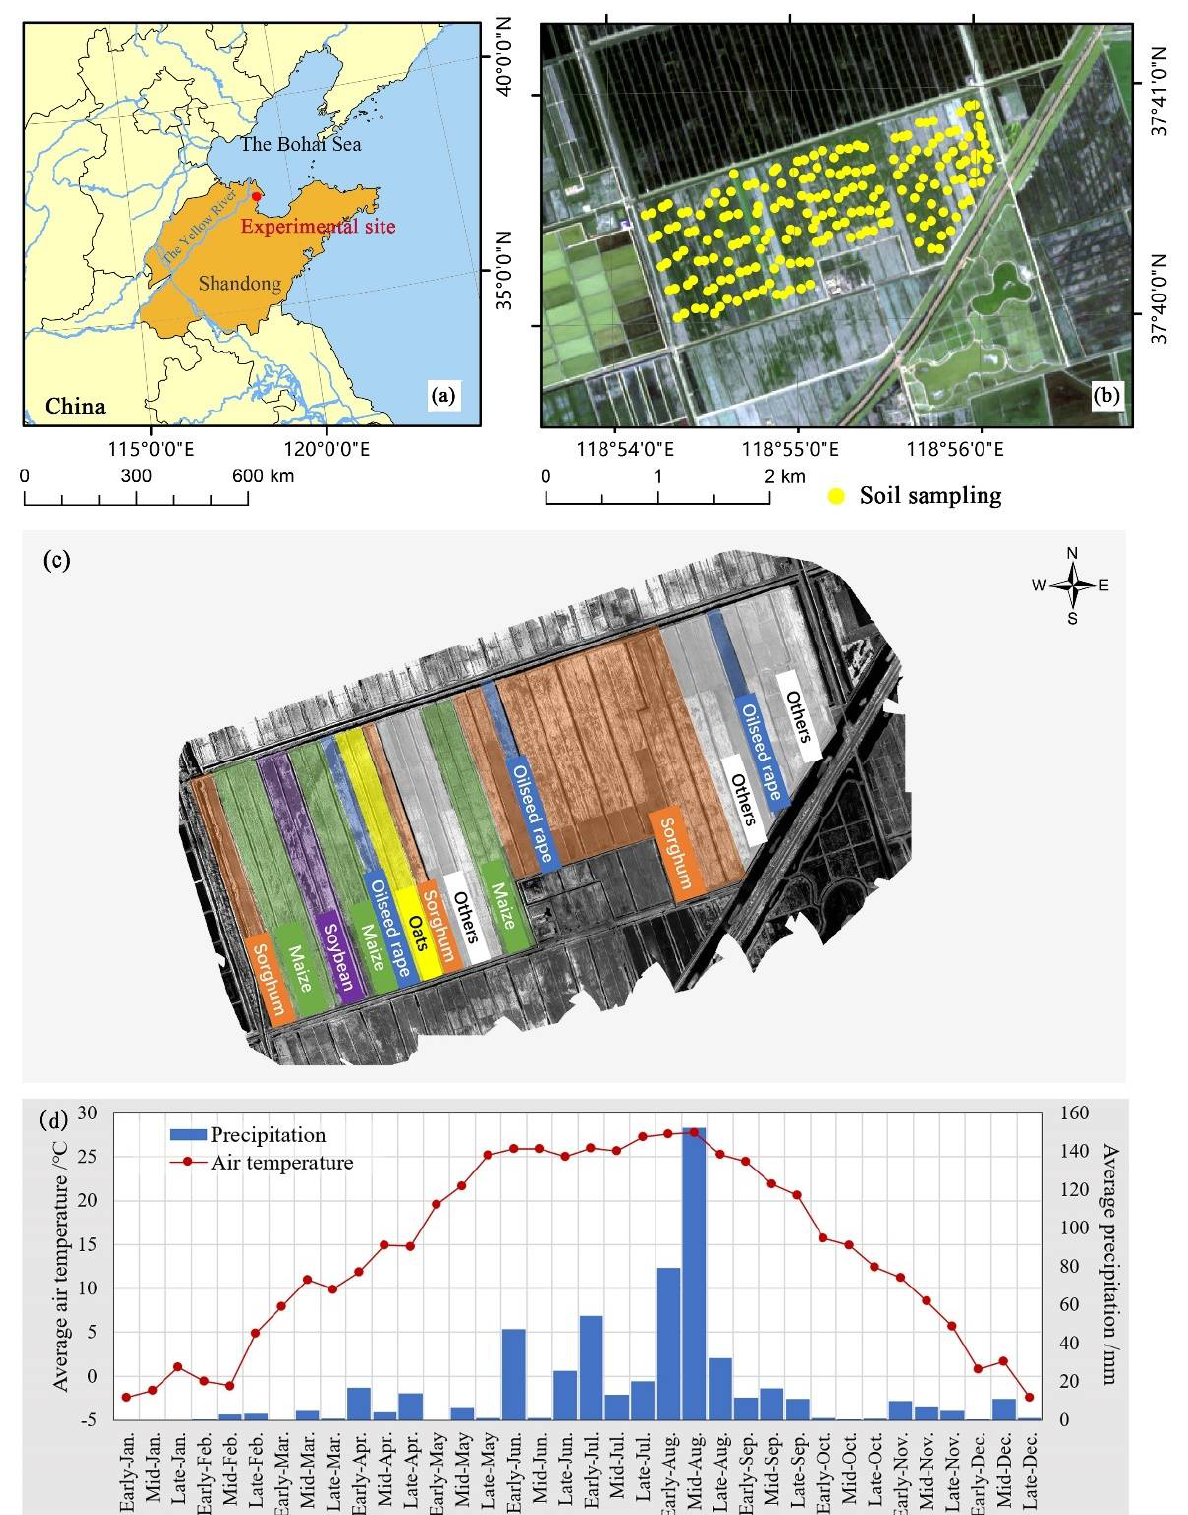
Figure 1. ( a ) Location of the study area; ( b ) distribution of the 195 soil sampling points; ( c ) crop distribution of the experimental site; and ( d ) precipitation and air temperature of the study area in 2019 (data was downloaded from http://sd.cma.gov.cn/gslb/dysqxj/qxfw/nyqx/index_3.html, accessed on 30 June 2021).